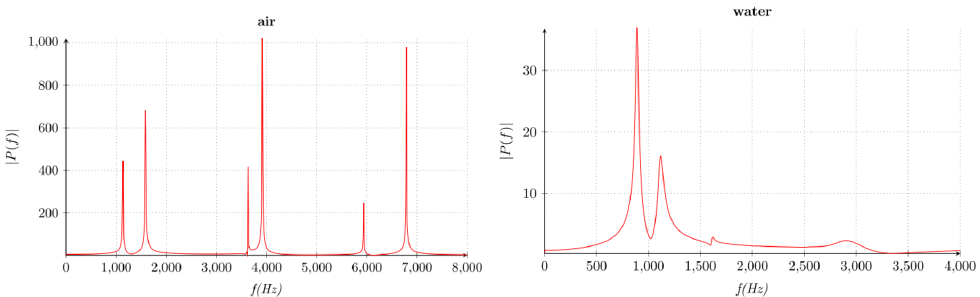
Figure 16. Spectral Analysis for FSI simulation on air and on water